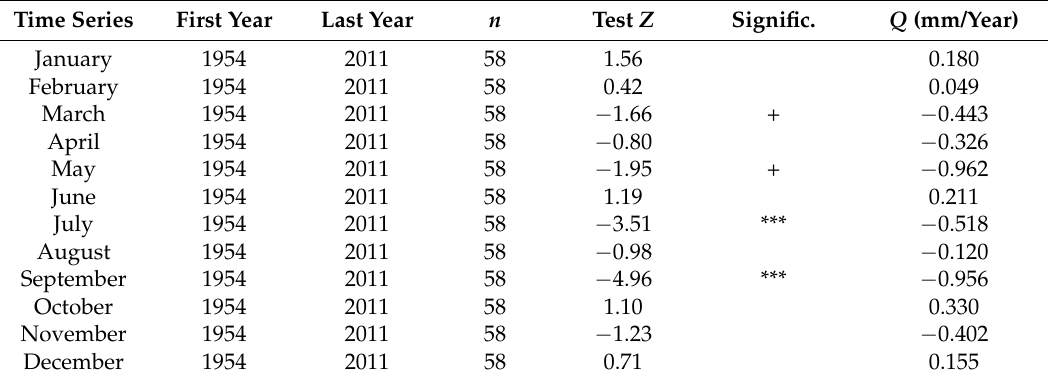
Table 3. Mann-Kendall trend and Sen’s Slope for Tanga’s monthly moving average rainfall